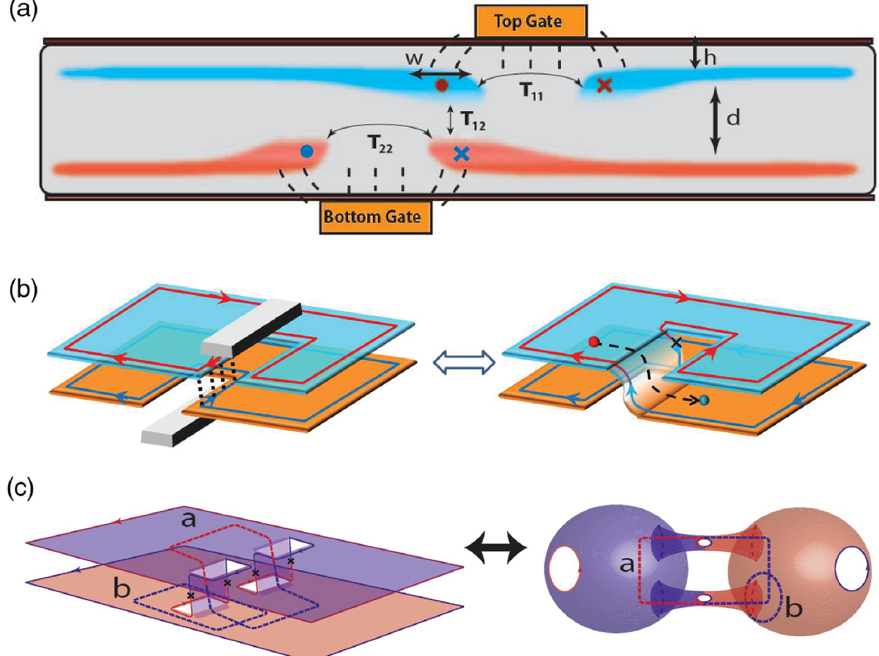
FIG. 1. (a) Cross section of proposed device. Top and bottom gates partially deplete the electron fluids, and the fringe fields cause the wave function at the edges to extend farther vertically, enhancing the tunneling. Filled circles and crosses indicate the gapless chiral edge states, moving out of or into the page. (b) 3D view. Interlayer backscattering between edge states smoothly connects the layers, allowing for coherent quasiparticle propagation between layers. The red and blue balls connected by a dashed line illustrate an interlayer path of the quasiparticle. (c) A pair of TLJs introduces two noncontractible loops, labelled a and b , so the space is topologically equivalent to a torus. The edge states around the outer edge of the sample and around the gates are mapped to edge states around four holes on the surface of the torus. In both (b) and (c), the genons (zero modes) are depicted with “ x ” at the ends of the